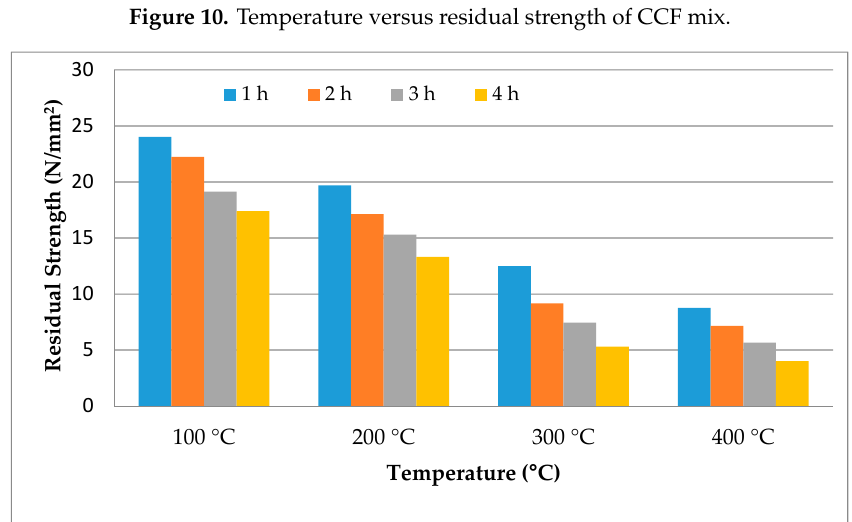
Figure 11. Temperature versus residual strength of CSC Figure 10. Temperature versus residual strength of CSC mix.